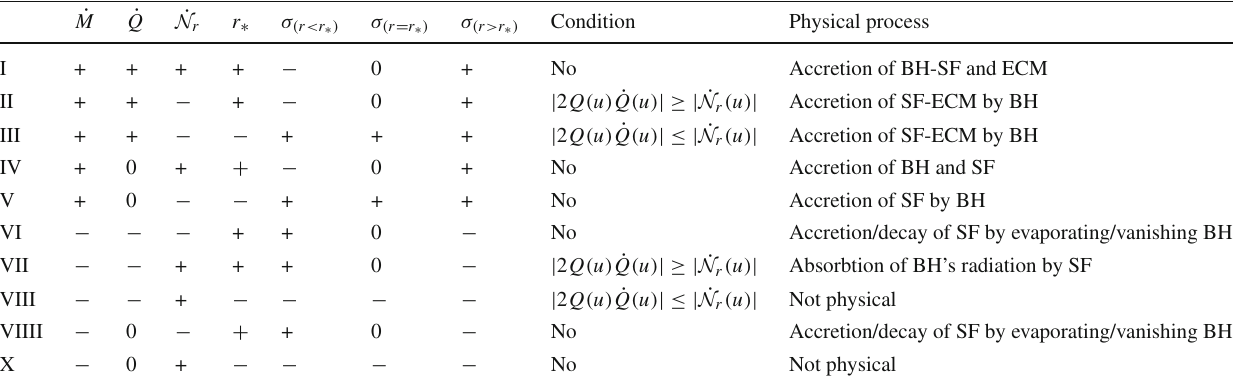
Table 4 General Bonnor–Vaidya BH and its radiation SF parameters for (cid:2) = + 1